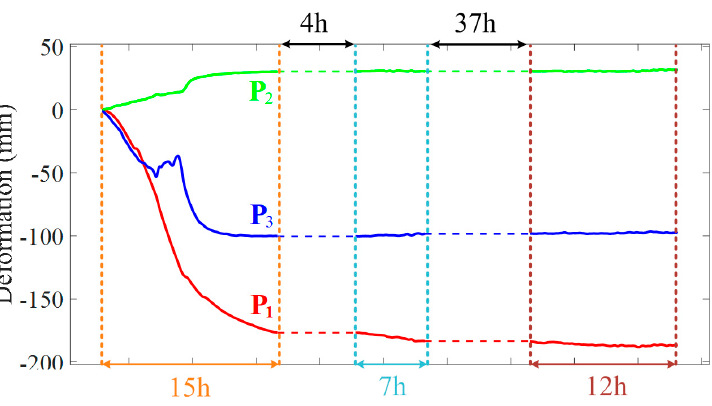
Figure 7. Deformation time series of typical points.